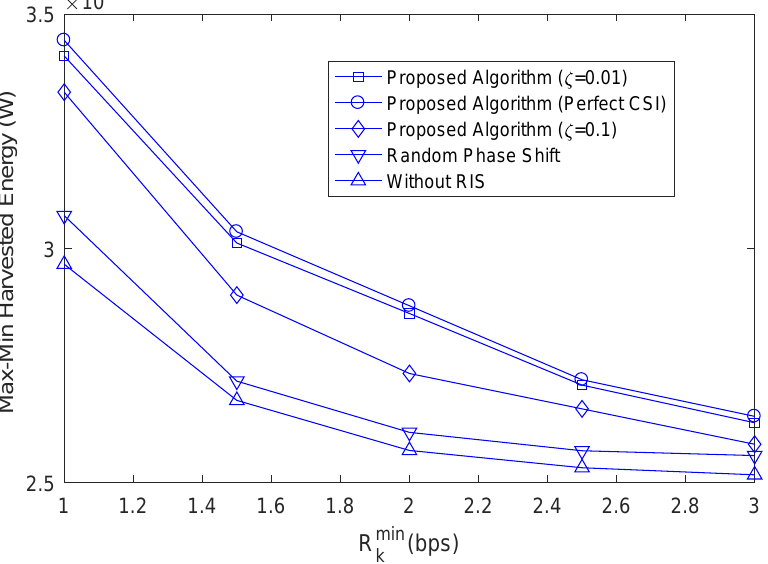
Figure 6. The relationship between the max-min harvested energy and the user secure rate